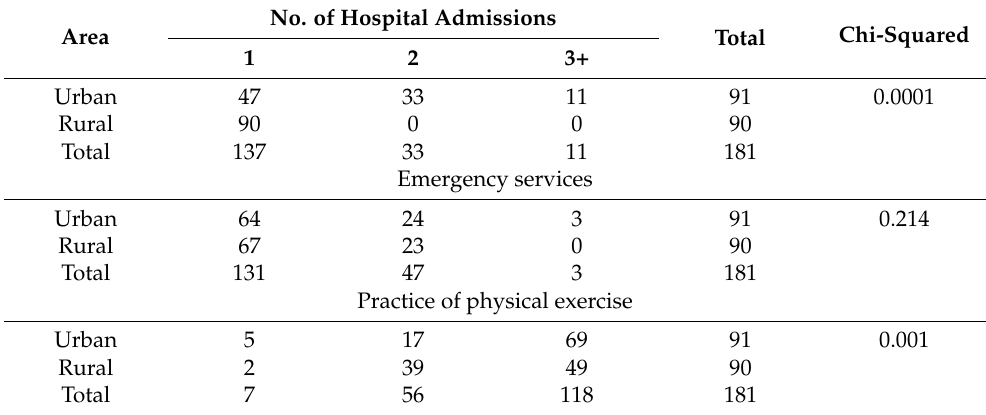
Table 4. Calculation of frequencies and association between health variables as a function of the participation in the educational organization or not of at-risk